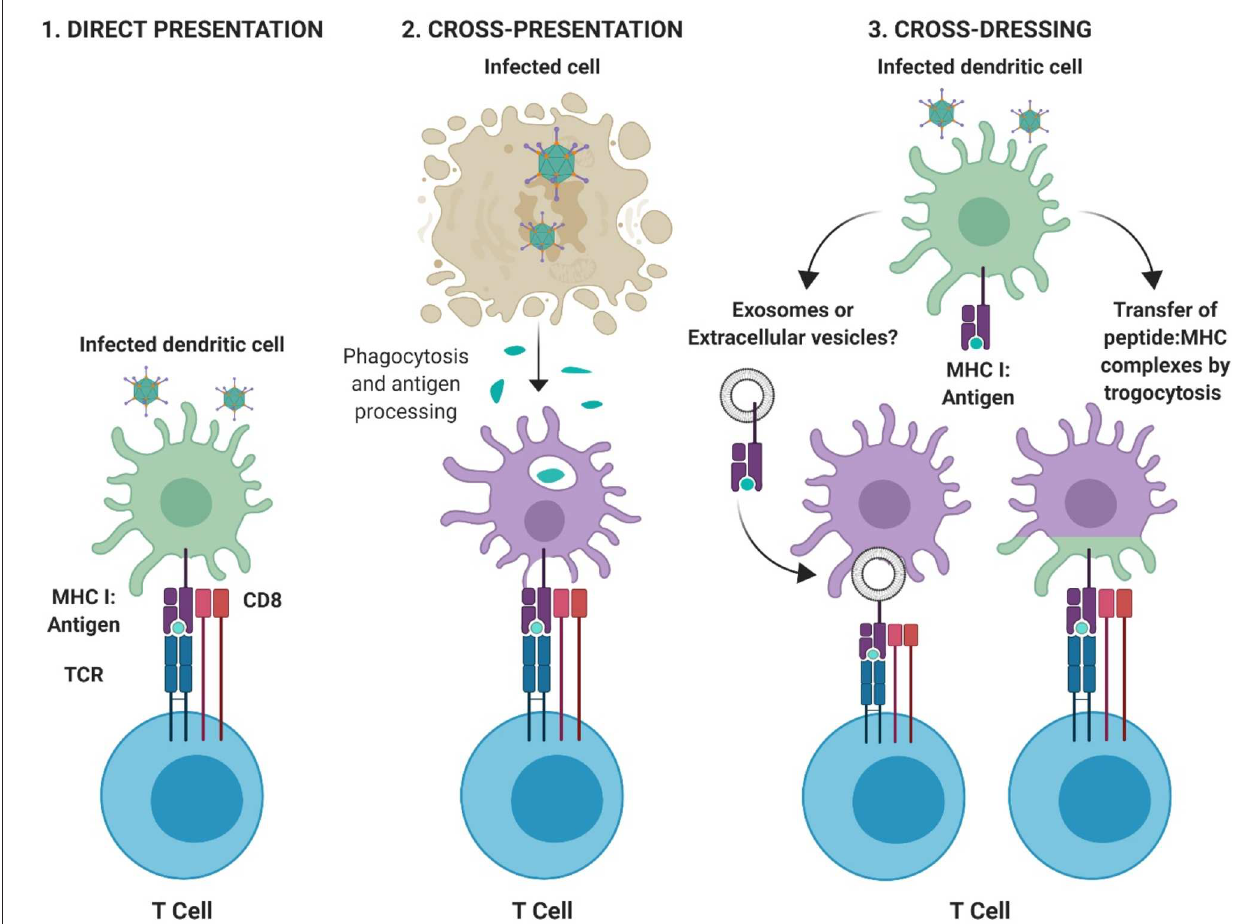
FIGURE 3 | Pathways for antigen presentation. (1) Direct-presentation: Antigen from virally infected cells is degraded by the proteasome and processed for peptide presentation to CD8 + T cells on MHC I. (2) Cross-presentation: Antigen fragments derived from virally infected cells are phagocytosed by professional APCs and peptide processed and presented to T cells via appropriate MHC molecules. (3) Cross-dressing: Peptide:MHC complexes can be acquired through transfer via extracellular vesicles or exosomes, or by a process of membrane gnawing called trogocytosis. Figure is adapted from Yewdell and Dolan ( 85) and was created with © BioRender -